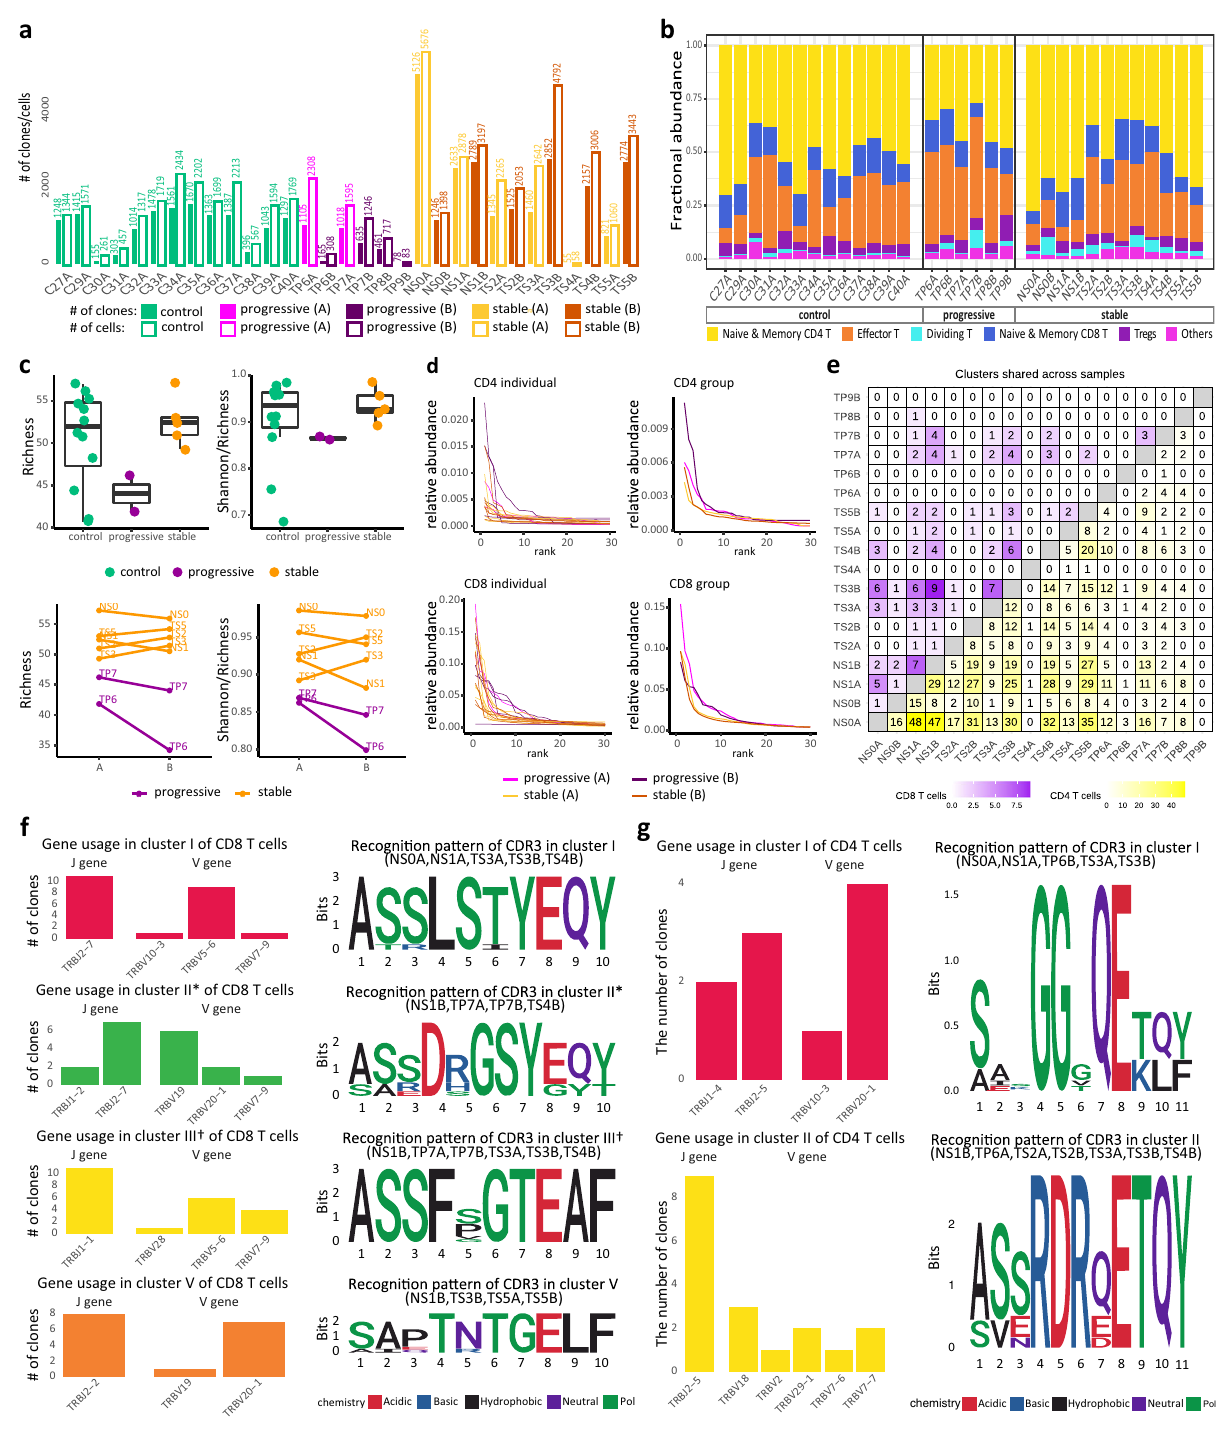
(Fig. 8h, i). We identi fi ed 20 expanded clones (ECs, as de fi ned in Methods section) with members found in 15/18 samples con- taining 1157/7177 cells (16% of all B cells). Plasma cells were signi fi cantly enriched in the ECs (mean = 78% across all samples; mean odds ratio = 5.7; p -value < 0.01) (Fig. 8h). ECs in samples TP7A and TP7B did not contain any plasma cells. IGHG cells were signi fi cantly enriched in ECs from tocilizumab-stable patients (mean = 84% across 6 samples, mean odds ratio = 8.2; p -value < 0.01) IGHM cells were enriched in ECs from